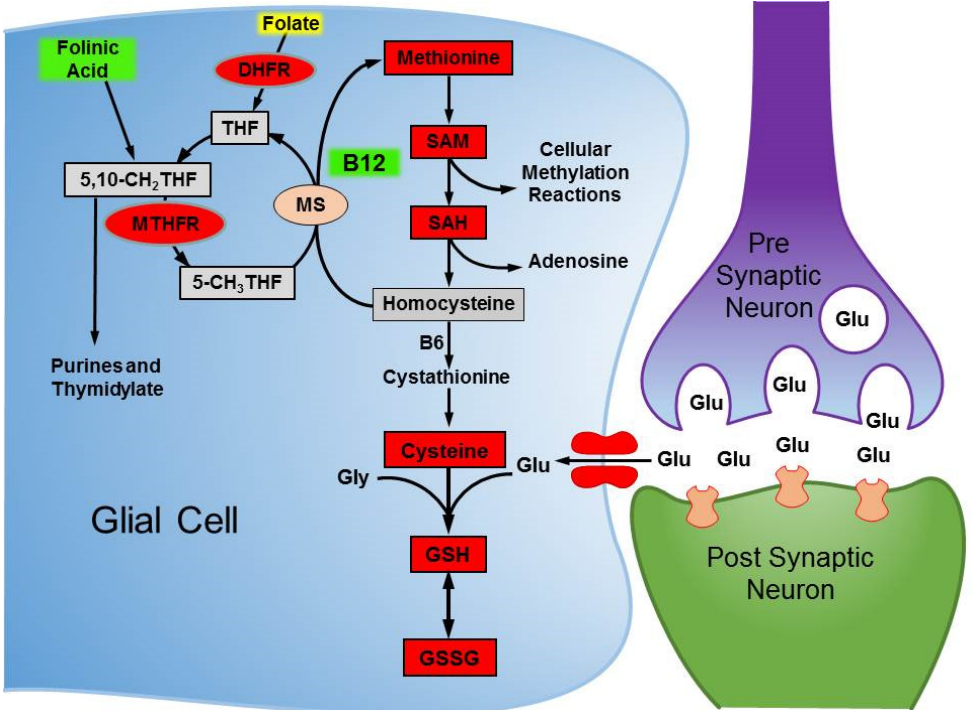
Figure 3. The production of glutathione results in the consumption of glutamate, the major excitatory neurotransmitter of the cortex, thus reducing glutamate in the brain. This diagram shows the connected folate, methylation, and redox metabolic pathways in the brain. Ovals represent enzymes and boxes represent metabolites. Red indicates metabolites and enzymes repeatedly noted to be consistently abnormal in ASD. Green highlights treatments that improve the metabolism of these cycles. Folic acid is shown in yellow as it is a suboptimal treatment because it is oxidized and has to be converted to active forms of folate.